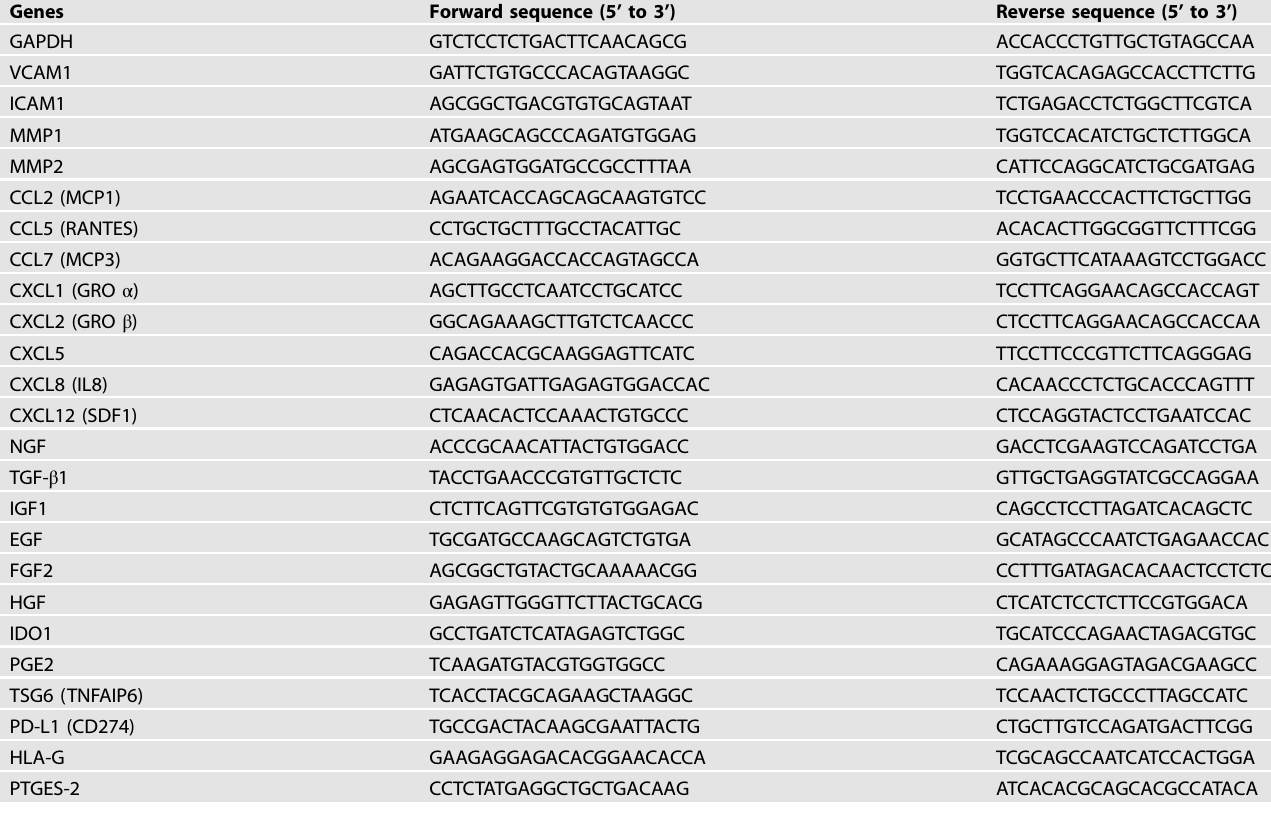
Table 1. Primers used for the ampli fi cation of human transcripts by real-time quantitative PCR. Genes Forward sequence (5 ’ to 3 ’ ) Reverse sequence (5 ’ to 3 ’ )